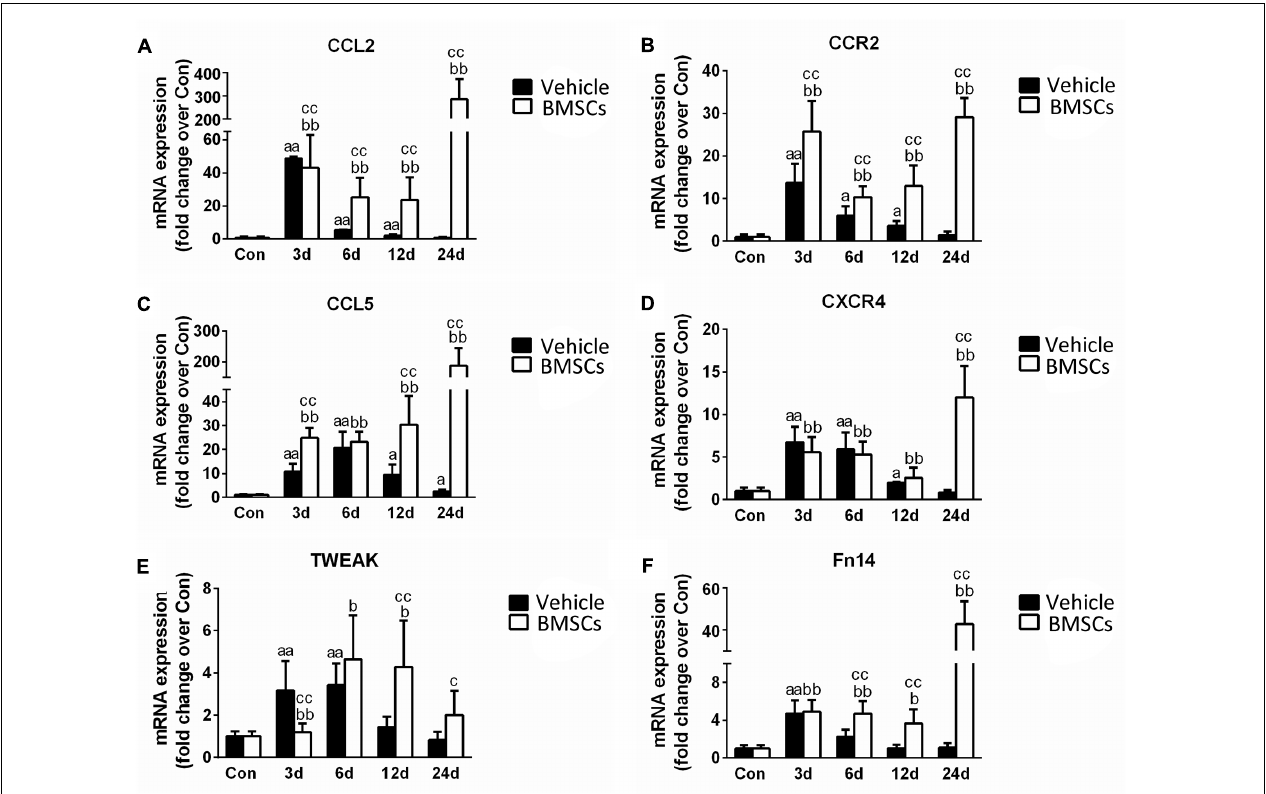
FIGURE 8 | The effects of BMSCs treatment on the expression of chemokines. Vehicle, muscle contusion and vehicle treated group; BMSCs, muscle contusion and BMSCs treated group. (A–F) The expression of chemokines after skeletal muscle injury. Data are means ± S.D., n = 8; a Significant difference from control, P < 0.05; aa P < 0.01. b Significant difference from control, P < 0.05; bb P < 0.01. c Significant difference from the same time points of group vehicle, c P < 0.05; cc P <